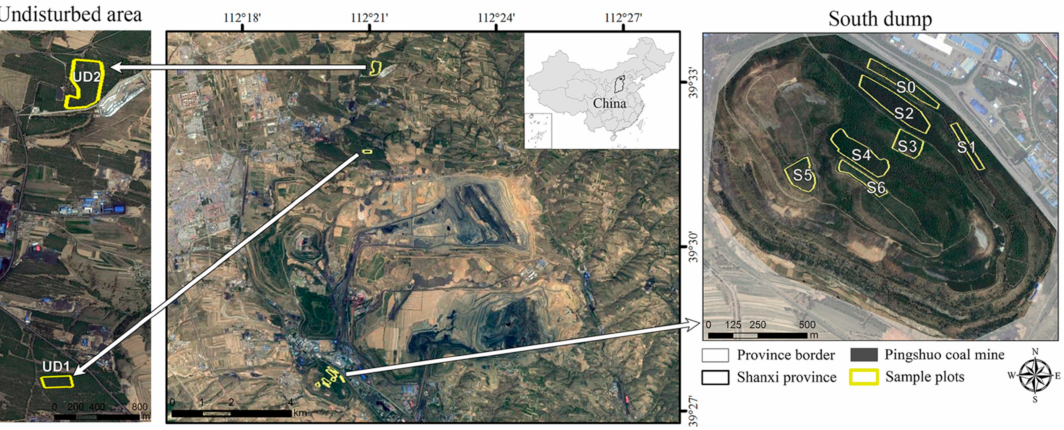
Figure 1. Study area and sample